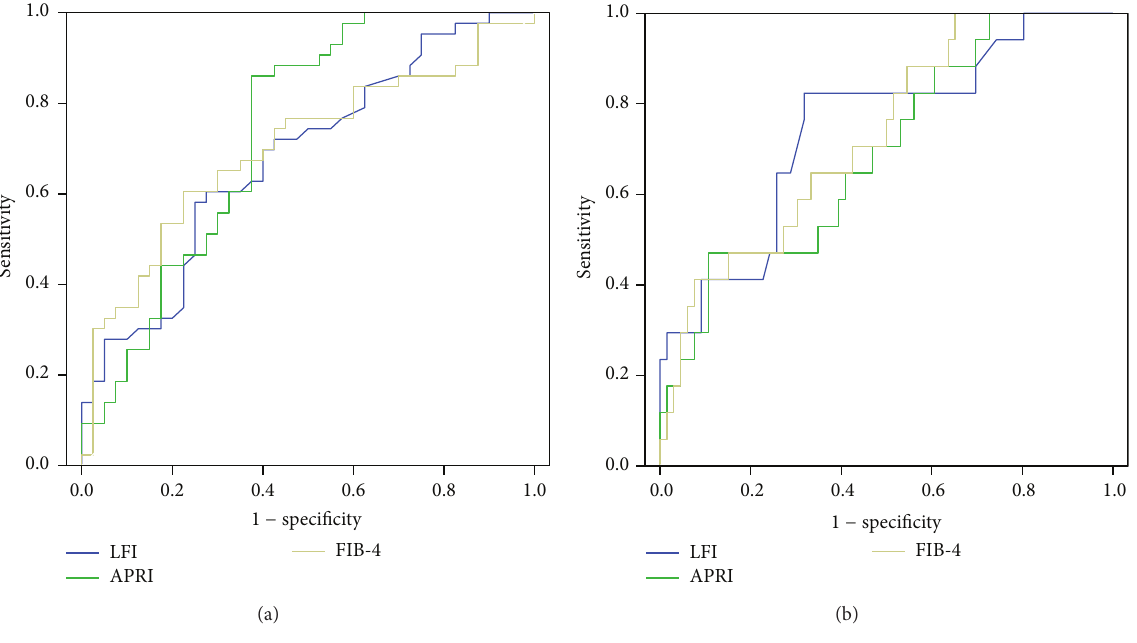
Figure 2: Receiver operating curves (ROC) curve of liver fibrosis index (LFI), aspartate transaminase platelet ratio index (APRI), the FIB-4 index for the prediction of advanced fibrosis (stage ≥ F3, (a)), and cirrhosis (stage F4,